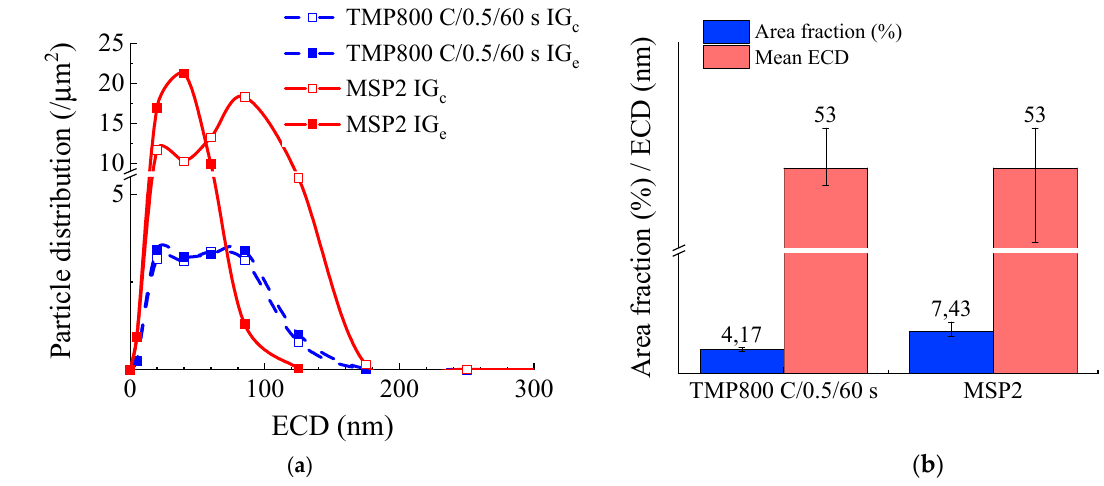
Figure 5. Quantitative image analysis results of ( a ) particle size distribution and ( b ) averaged particle area fractions against averaged ECDs (equivalent circle diameter) of intragranular precipitates.